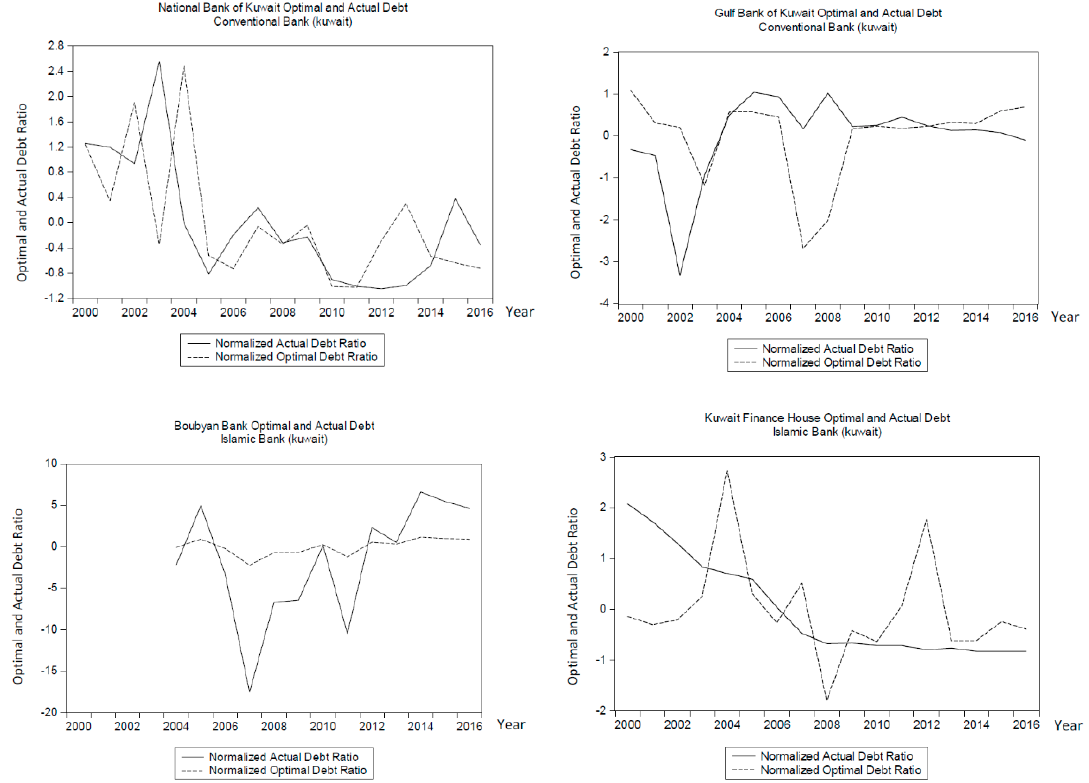
Figure 2. Kuwait optimal- versus actual-debt ratio. Source: Author’s calculations.